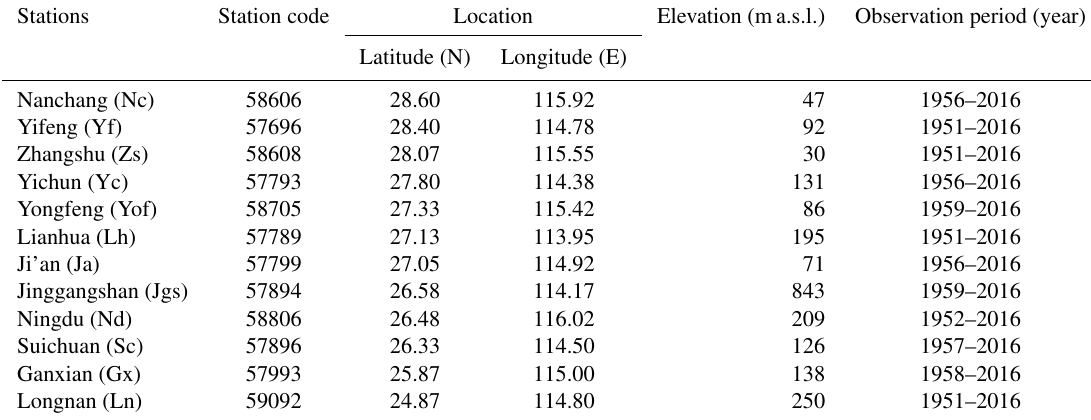
Table 1. Characteristics of the selected meteorological stations.